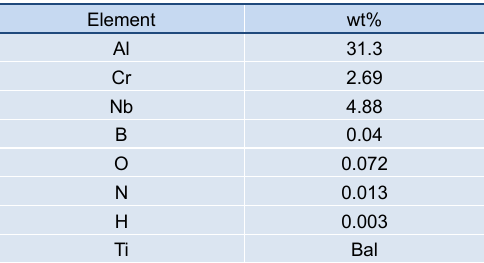
Table 2 | The main technical parameters of high energy nanosecond pulsed Nd: YAG